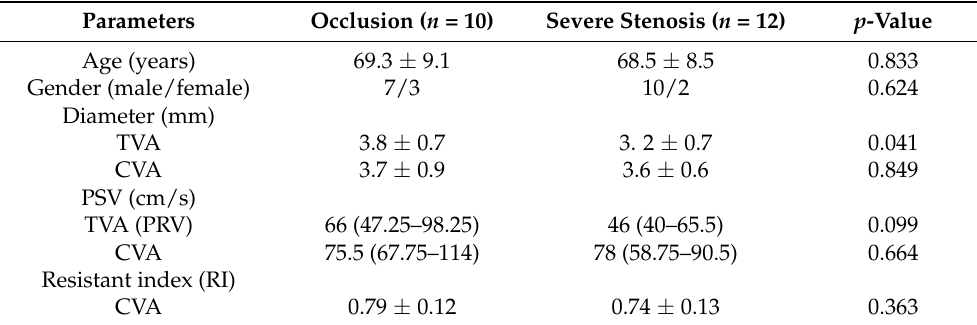
Table 5. Parameters of VA ultrasound in 22 patients with ICRF in the VA between the SA occlusion group and the severe stenosis